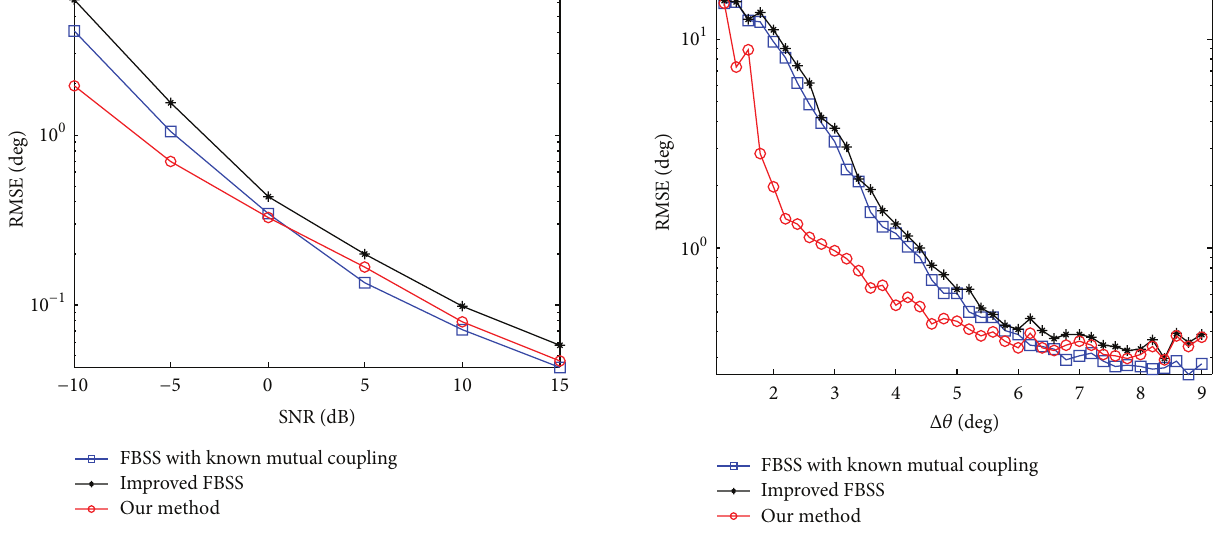
Figure 1: RMSE of DOA estimates against SNR ( 𝑁 𝑐 = 𝑃 = 1 ).